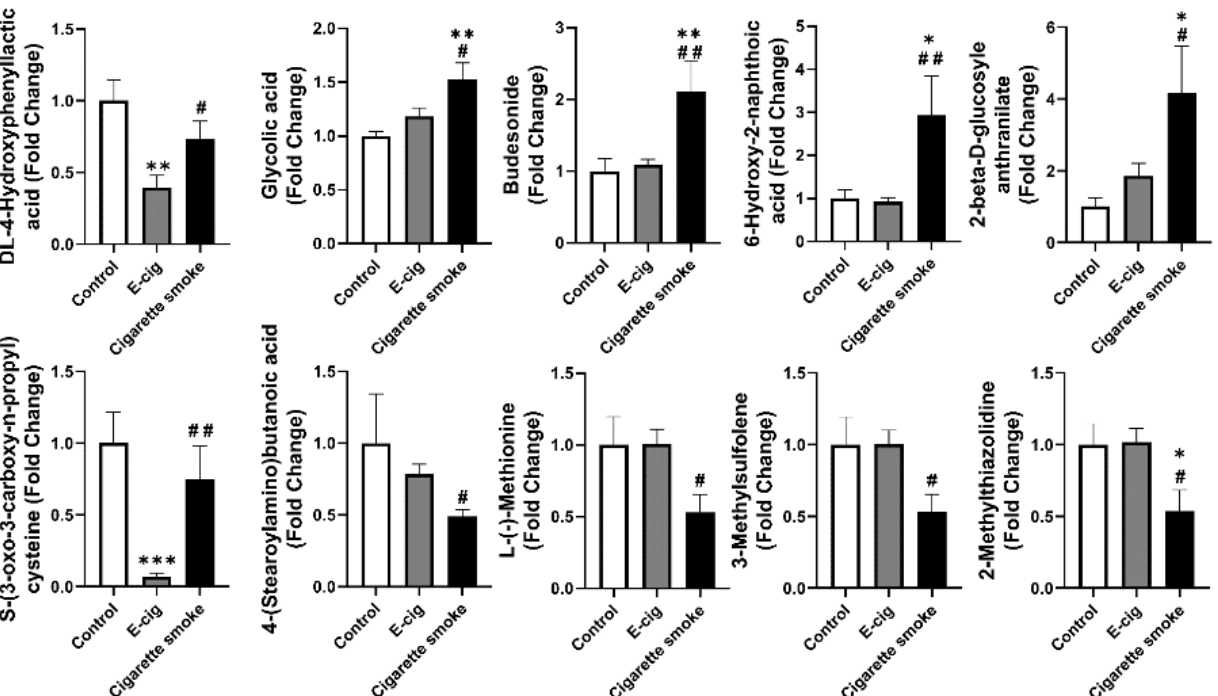
Figure 6. Metabolites from plasma analyzed from UPLC – MS from both negative and positive ion mode identified dysregulated metabolites in either e-cig users or cigarette smoker. Fold changes were calculated based on the normalized area from UPLC – MS spectra, and control groups were used as a baseline. Data are shown as mean ± SEM ( n = 6 for non-smoking control and cigarette smoke groups, n = 12 for e-cig group; * p < 0.05, ** p < 0.01 vs. non-smoking control; # p < 0.05, ## p < 0.01 vs. e-cig).